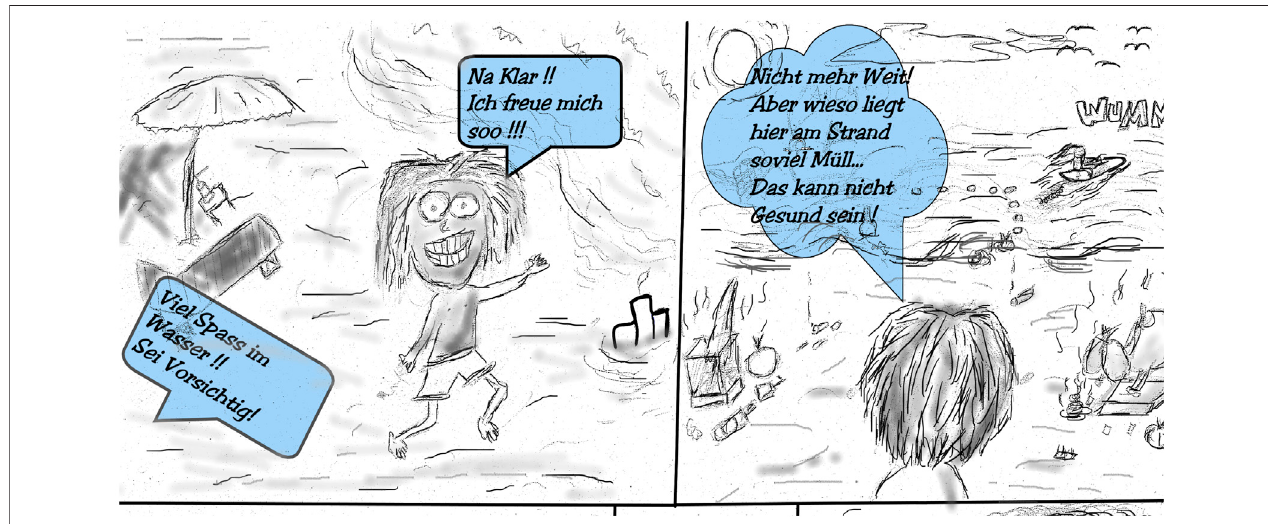
FIGURE7| Usinganexpressivedrawingstyletorepresentthesubjectiveperceptionofspace.Inthesecondpanelthereadershouldtakeontheperspectiveofthe protagonist.Thetextinthespeechbubblesreadsasfollows: “ Havefuninthewater!!Becareful! ” , “ Surething!!I ’ msoexcited!!! ” , “ Almostthere!Butwhyistheresomuch garbage lying around at this beach ... This can ’ t be healthy! ” Image courtesy of H. Tunc.